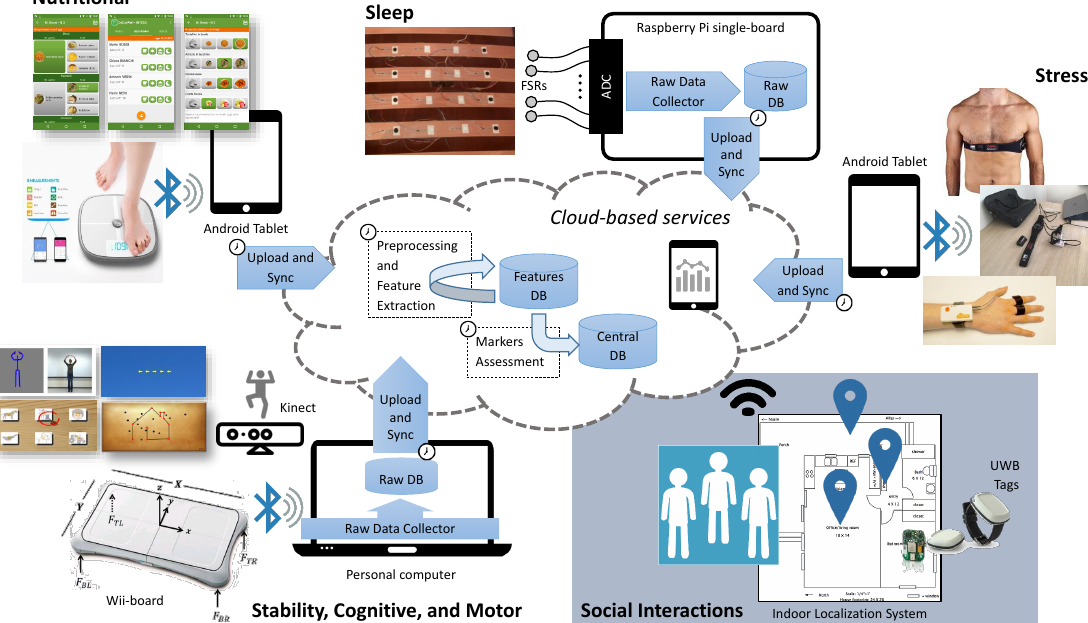
Figure 1. Overview of the deployed services with their devices, local gateways, cloud-based back-end